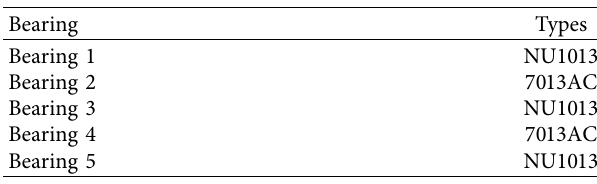
Figure 21: Experimental setup of the dual-rotor system with five supports. Table 5: Bearing type of the test rig.